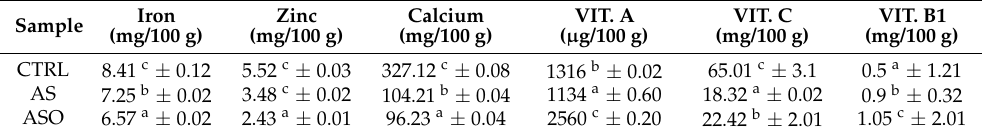
Table 4. Micronutrient value of the formulated complementary food (dry